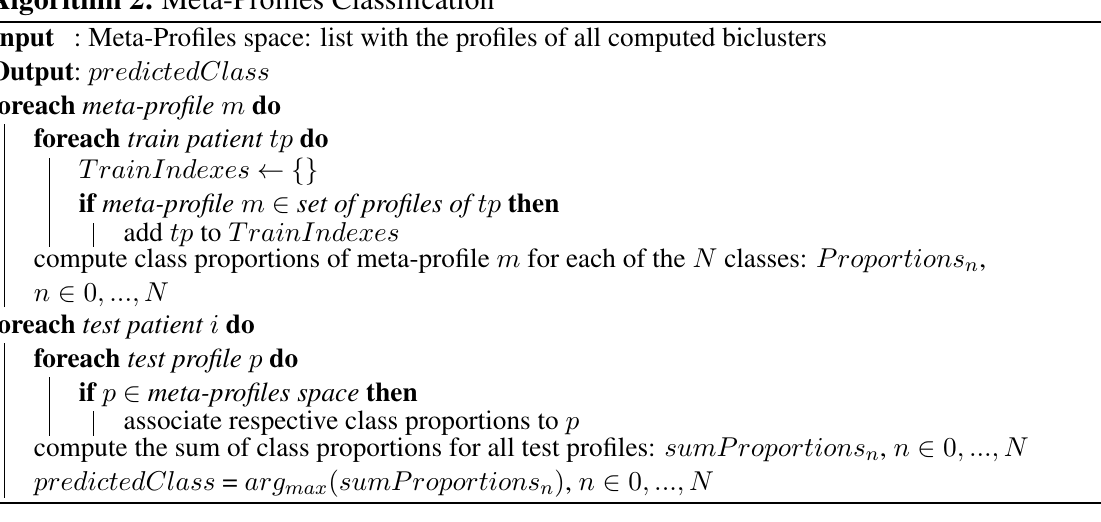
Algorithm 2: Meta-Profiles